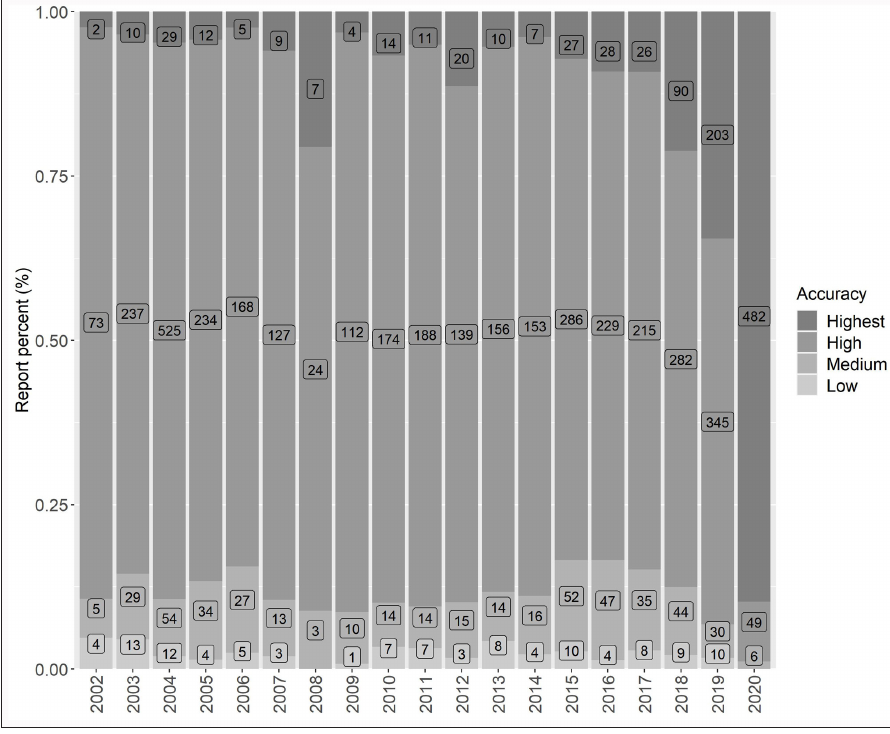
Figure 3 Ranking of the accuracy of public reports sighting locations over time. Highest accuracy requires GPS coordinates; high accuracy requires specifying the beach on which an observation was made; medium accuracy requires specifying the name of a nearby town; low accuracy requires specifying only the county in which an observation was made. Number of reports for each accuracy index is reported in bars by